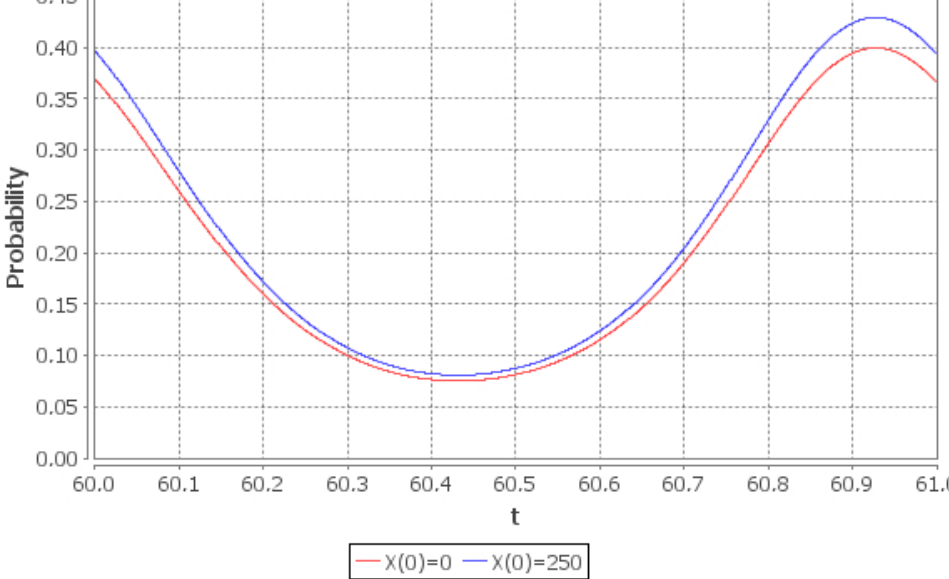
Figure 6. Limiting probability p 0 ( t ) of the empty queue given two different initial conditions: p 0 ( 0 ) = 1 ( red line ), p 250 ( 0 ) = 1 ( blue line